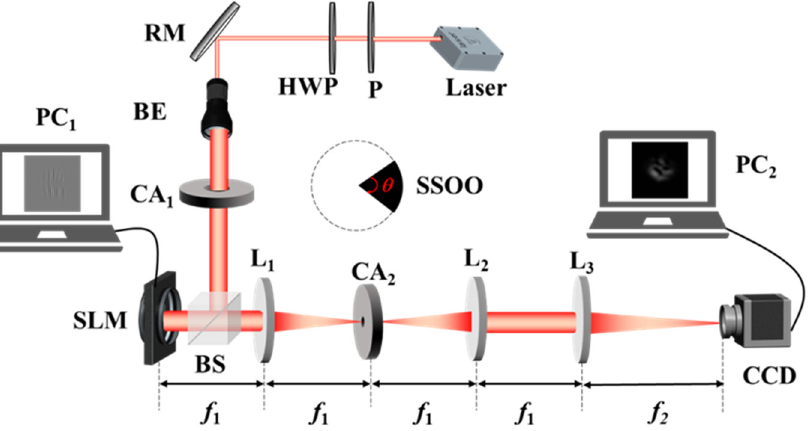
Figure 8. Experimental setup for generating a TLGSM beam. Laser, He-Ne laser; P, linear polarizer; HWP, half-wave plate; RM, reflecting mirror; BE, beam expander; CA 1 , CA 2 , circular apertures; BS, beam splitters; SLM, spatial-light modulator; L 1 , L 2 , L 3 , thin lenses; CCD, charge-coupled device; PC 1 , PC 2 , personal computers.